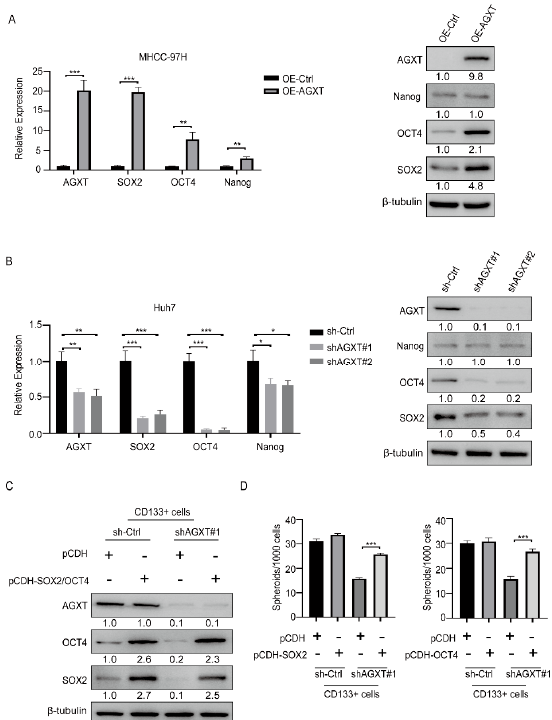
Figure 4. Alanine − glyoxylate aminotransferase (AGXT) upregulates stemness transcription factors to maintain stemness properties in liver cancer stem cells: ( A ) quantitative real − time polymerase chain reaction (qRT − PCR) and Western blot analysis of transcription factors in AGXT − overexpressing MHCC97 cells; ( B ) qRT − PCR and Western blot analysis of the expression of transcription factors in AGXT knockdown Huh7 cells; ( C ) Western blot analysis of SRY − box transcription factor 2 (SOX2) and octamer − binding transcription factor 4 (OCT4) overexpression, and AGXT knockdown, in CD133 + cells; ( D ) statistical bar graphs of sphere numbers in SOX2-overexpressing or AGXT knockdown CD133 + cells (left) and OCT4 − overexpressing or AGXT knockdown CD133 + cells. Scale bar, 100 µ m. * p < 0.05, ** p < 0.01, *** p <